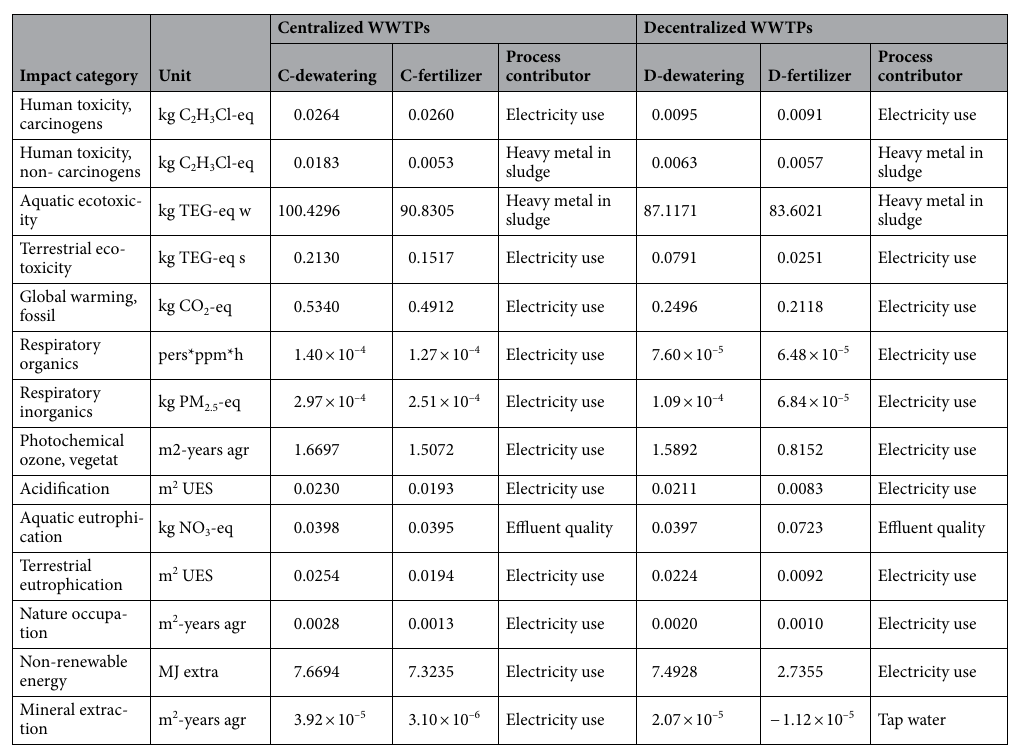
Table 2. Environmental impacts and process contribution analysis of the centralized and decentralized sludge treatment